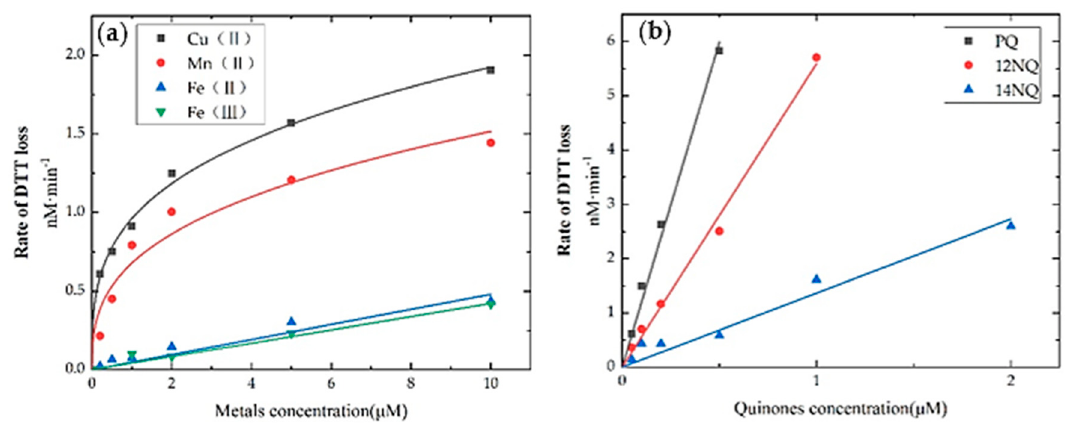
Figure 10. Rate of DTT loss as a function of concentration of redox-active species: ( a ) results for the four metals that oxidized DTT; ( b ) results for the three DTT-reactive quinones (present study, not published).